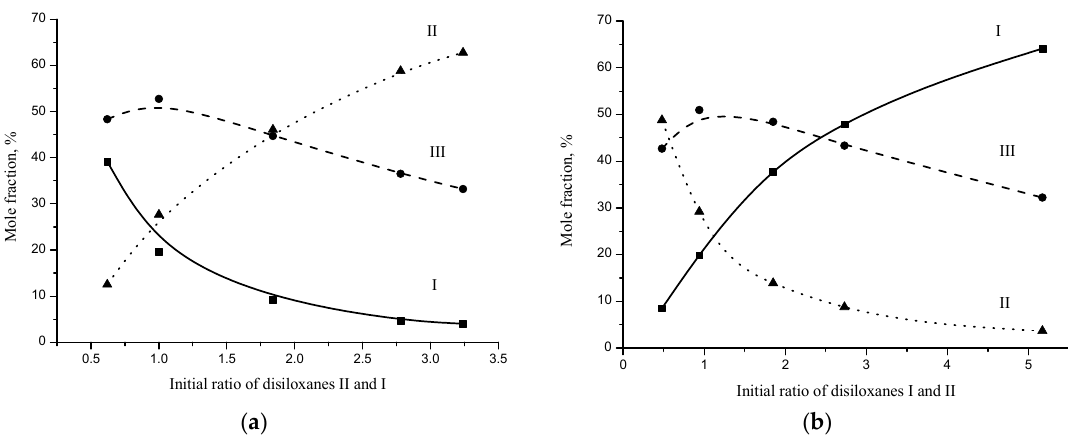
◦ C) at di ff erent initial molar ratios